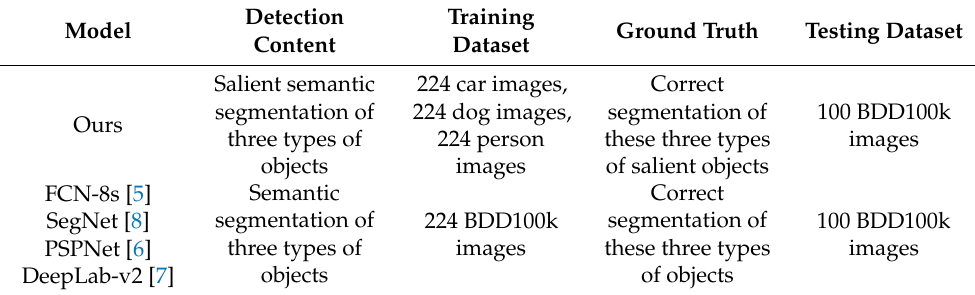
Table 9. Experimental arrangements.